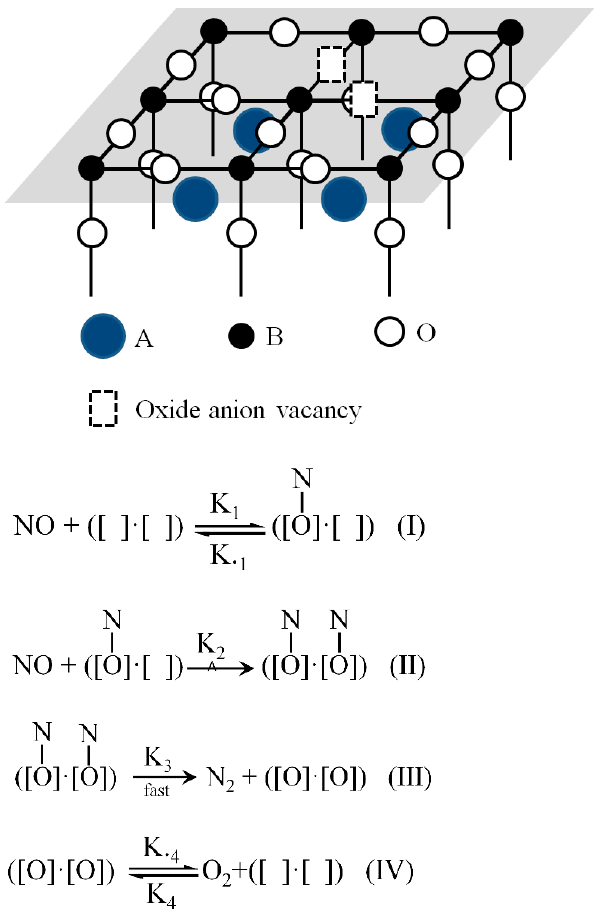
Figure 3. A possible reaction mechanism for the direct decomposition reaction of NO on perovskite-type oxides. Adapted with permission from [10], 2021, Royal Society of Chemistry.